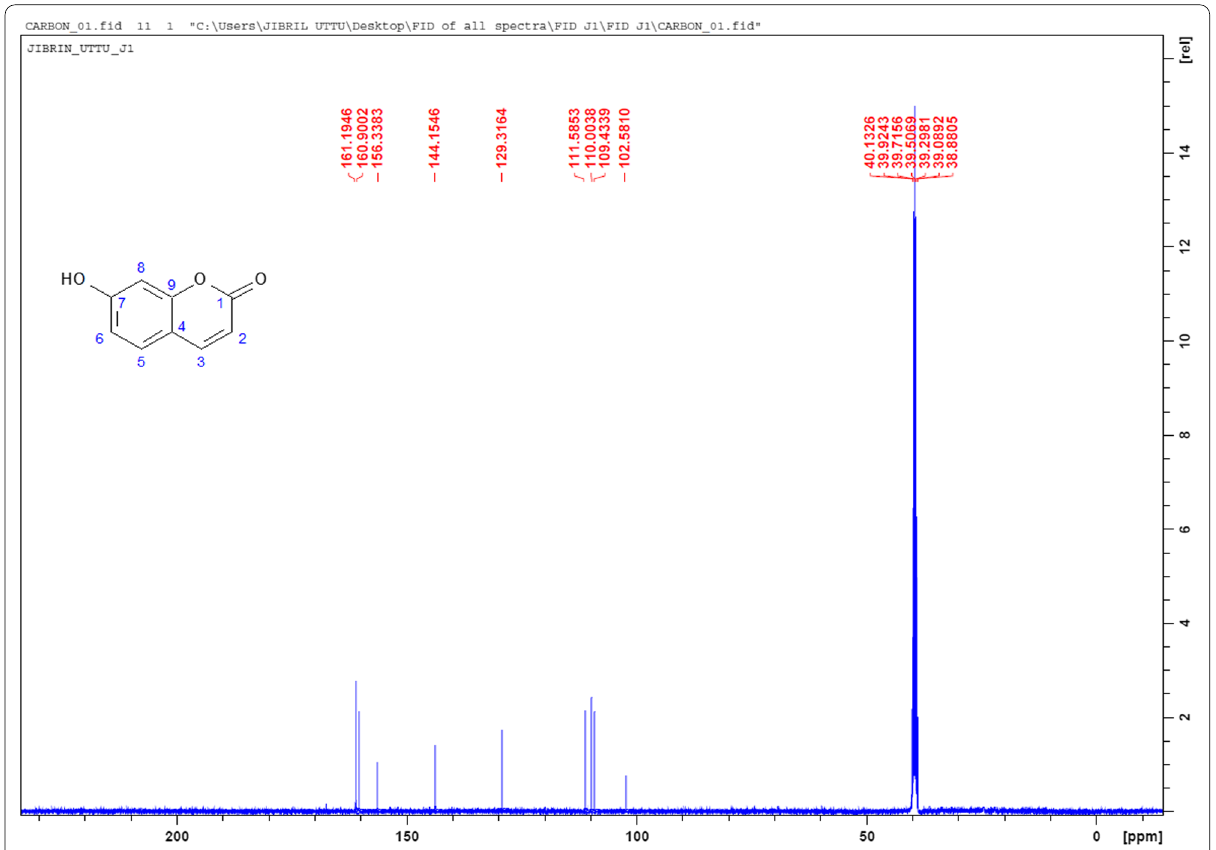
Fig. 3 13 C NMR spectrum for compound